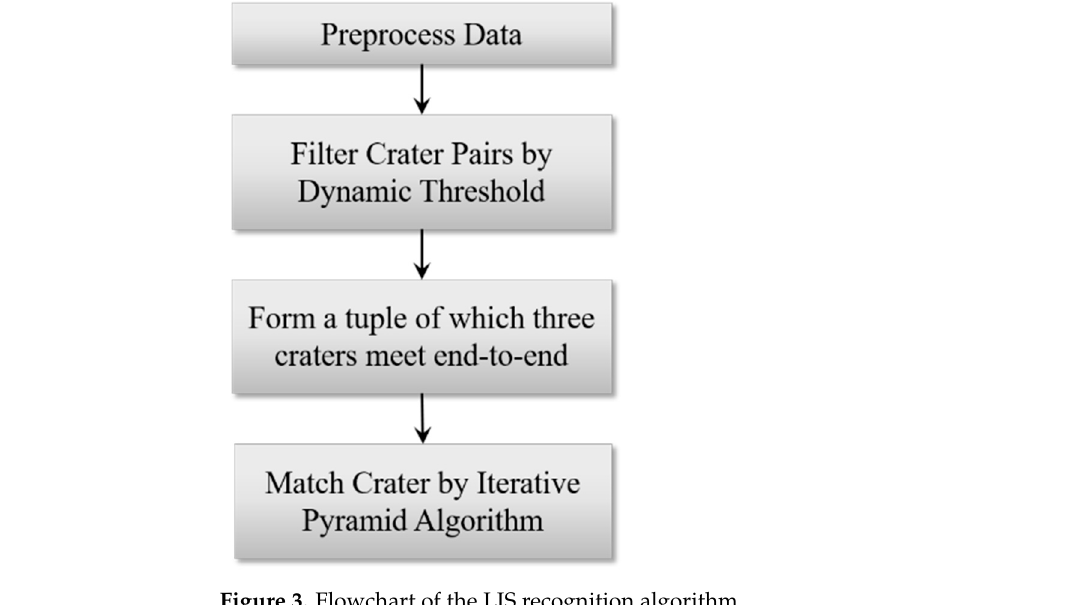
( d ) Figure 5. Description of dynamic threshold: ( a ) invariant distribution range 𝛥𝐼 (cid:3036)(cid:3037) of randomly se- lected crater pairs, ( b ) invariant 𝐼 (cid:3036)(cid:3037) of same crater pairs in Figure5 a , ( c ) (cid:3057)(cid:3010) (cid:3284)(cid:3285) |(cid:3010) (cid:3284)(cid:3285) | for different crater pairs, where the red line is for factor = 0.3 , and ( d ) invariant distribution of crater pairs of different sizes.